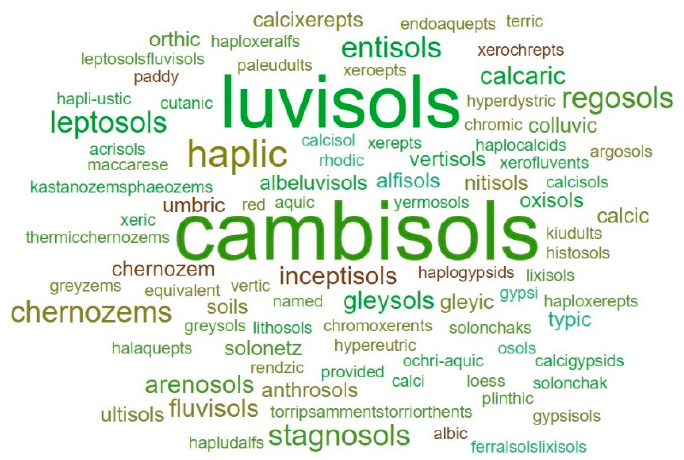
Figure 3. Word cloud of soil types considered in satellite-derived SOC published studies (word size varies with frequency).